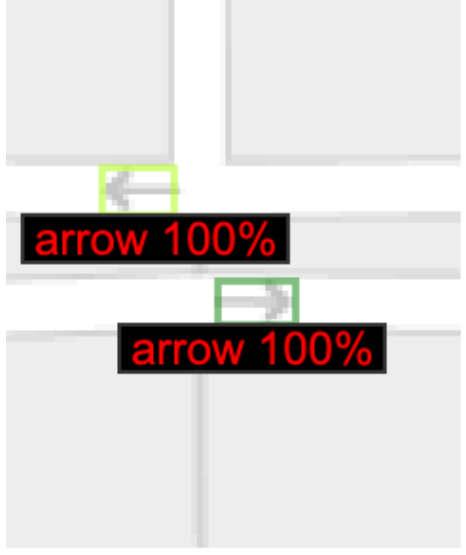
Figure 8. Arrow position detection for Bing Maps.